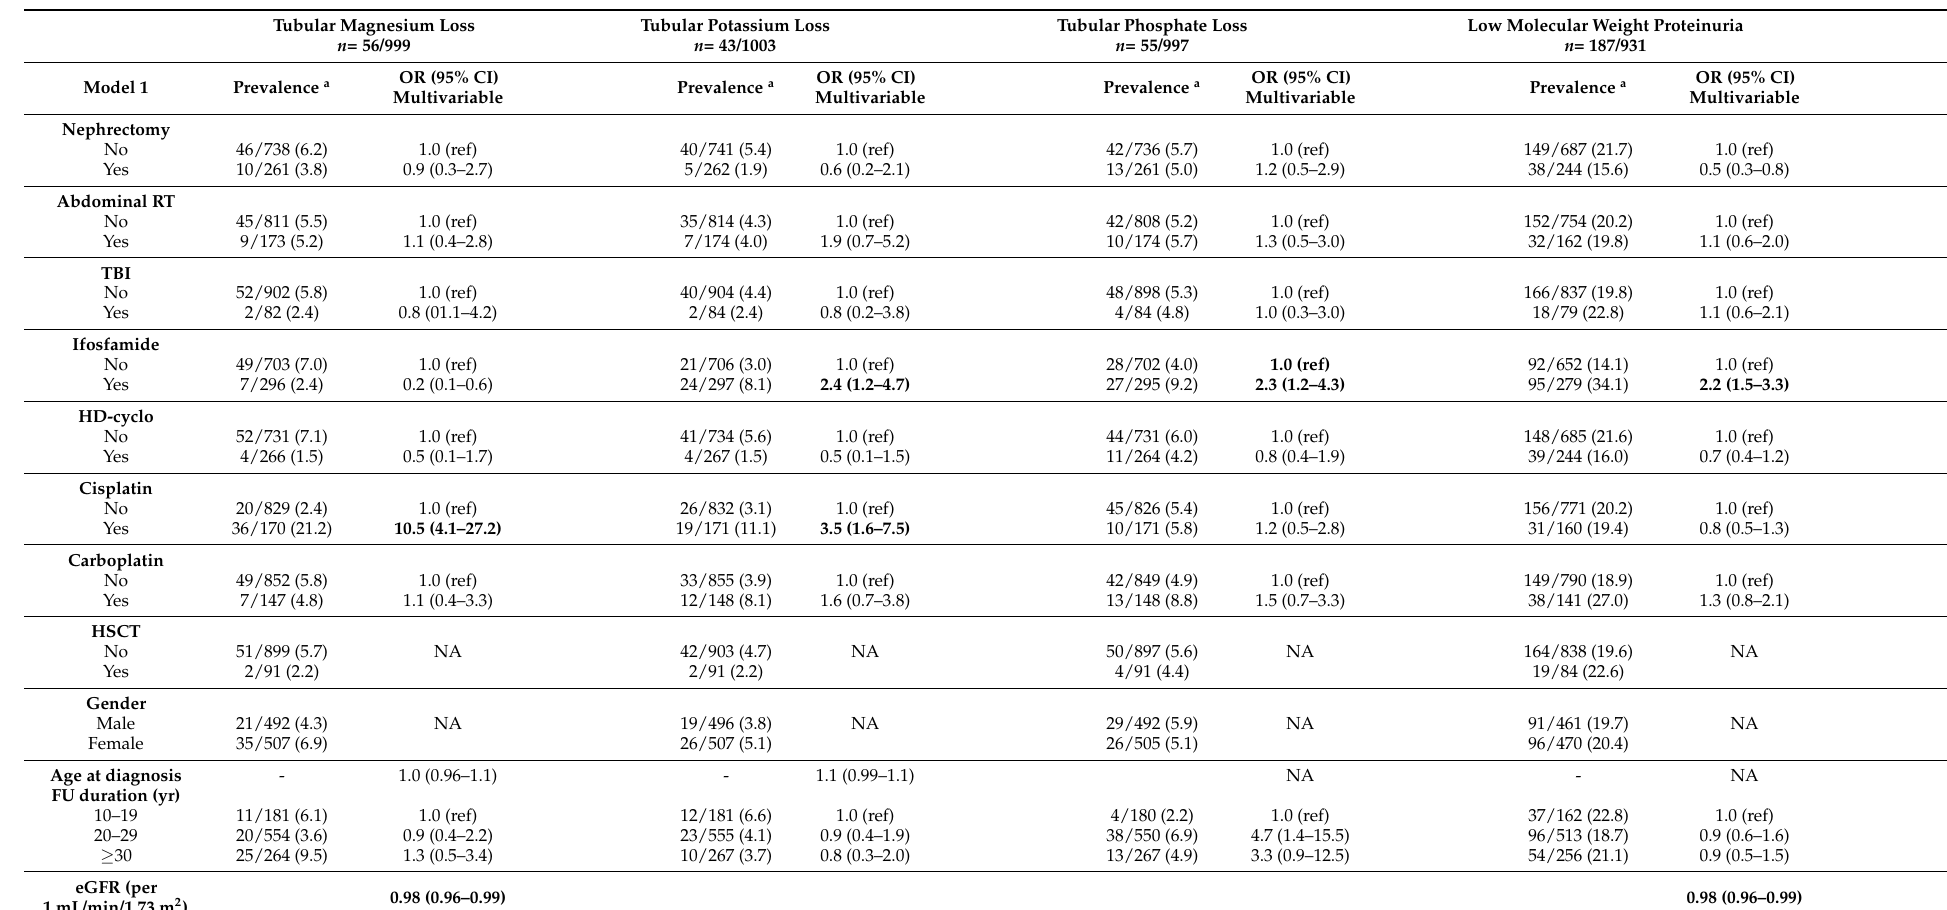
Table 6. Multivariable logistic regression analyses for tubular outcomes in childhood cancer survivors including independent treatment